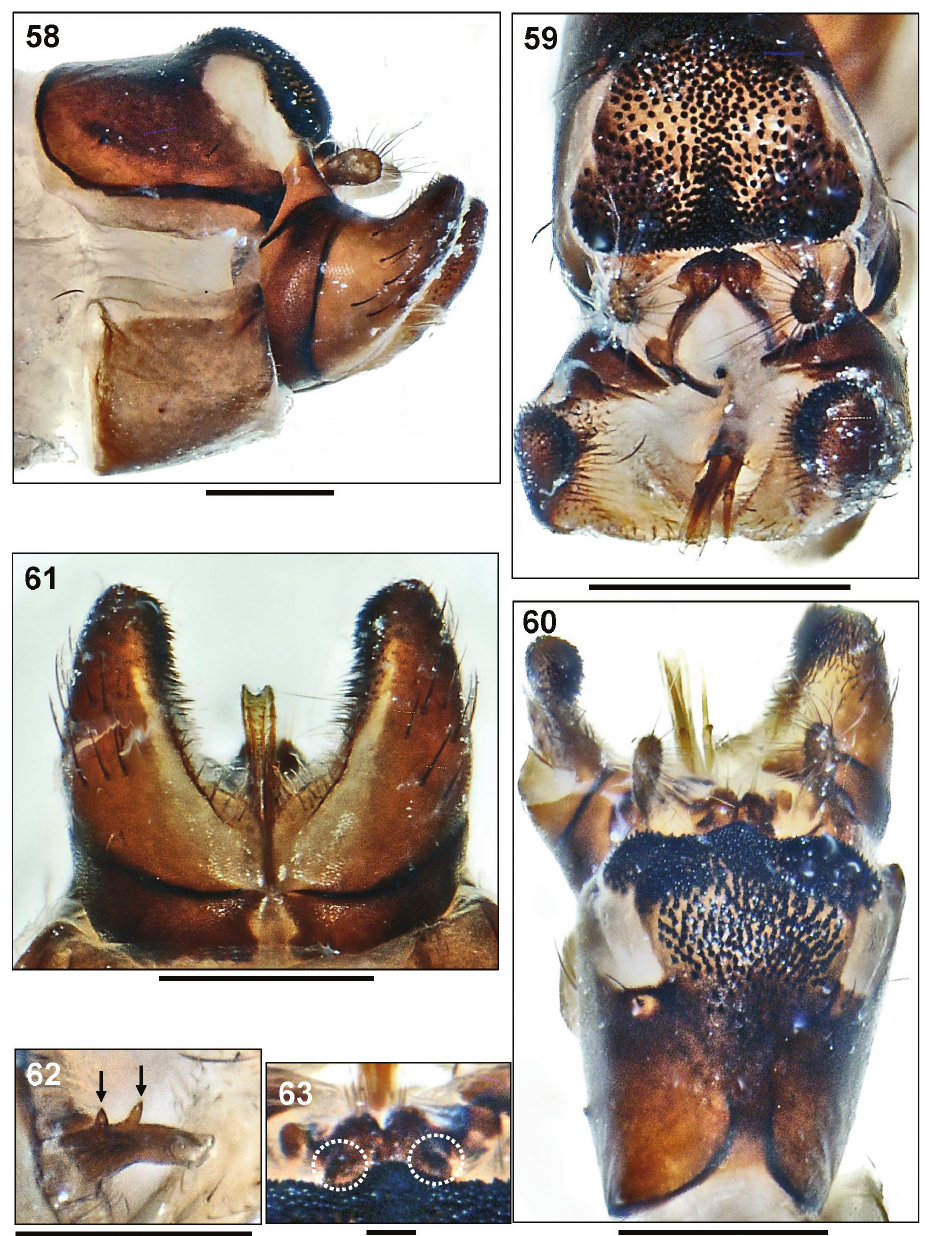
ovals: basolateral bulges). Scale bars: 0.5 mm (except Fig. 63: 0.1